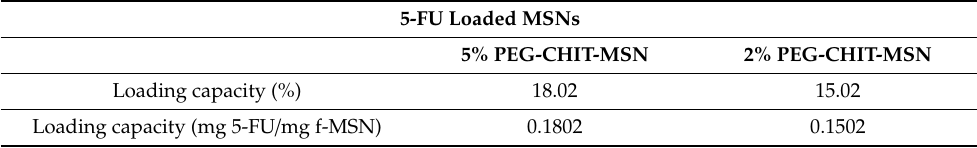
Table 3. Loading capacity of polymeric MSNs with 5-FU.